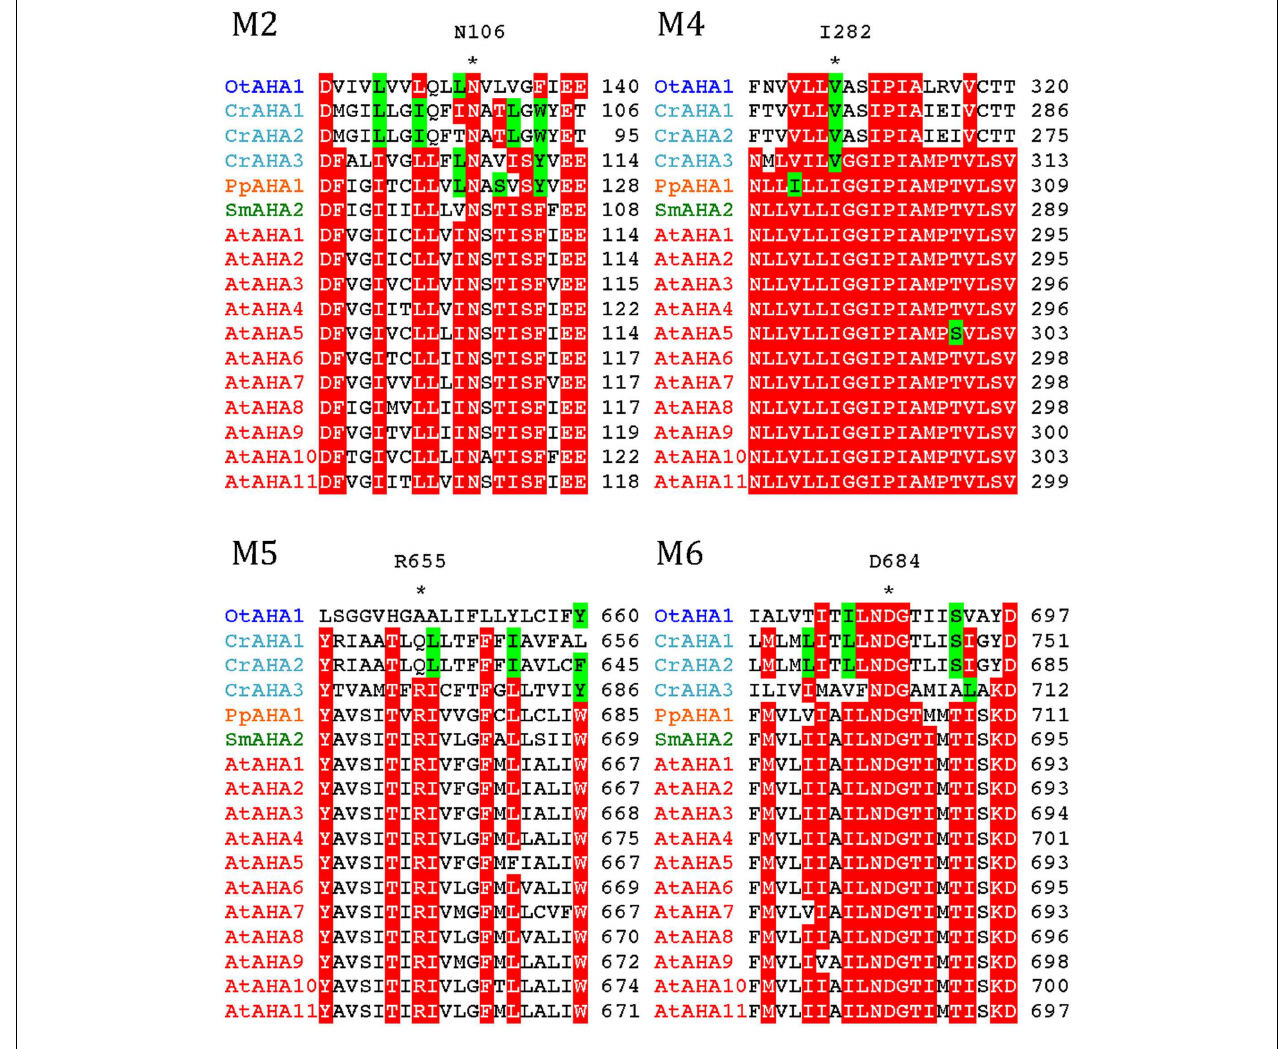
FIGURE 10 |Alignment of predicted transmembrane segments in P3A H + -ATPases. Asterisks mark residues of potential importance for proton coordination and pumping based on evidence from mutagenesis and analysis of a crystal structure for AtAHA2 (Pedersen et al., 2007).The